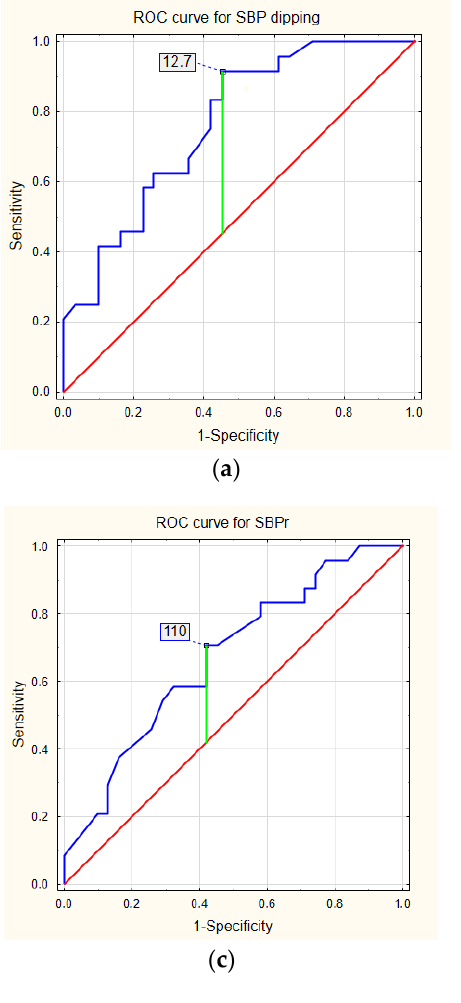
Table 4. Diagnostic accuracy of predicting annualized eGFR slope ≥ 3 mL/min/1.73 m 2 /year. SBP and DBP dipping acting as destimulants and DBPr and MAPr acting as stimulants.